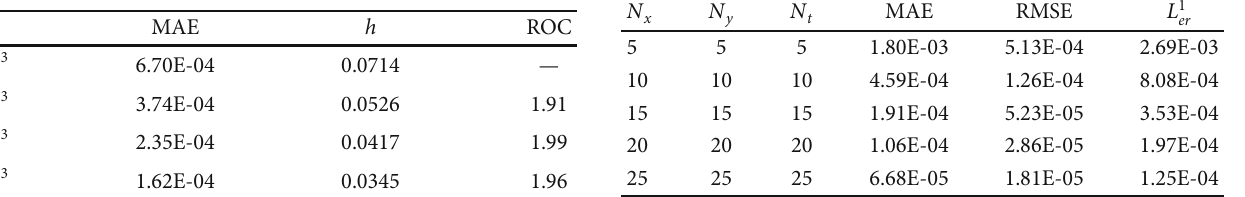
Figure 8: Exact (a) and numerical (b) solutions at t = π /2 for the Example 3 with N = 30 3 and ε = 5 . Table 10: Maximum absolute error and rate of convergence at t = T for di ff erent values of N in Example 3 using ε = 5 and Ω × ½ 0, 1 (cid:2) × ½ 0, π /2 (cid:2) .